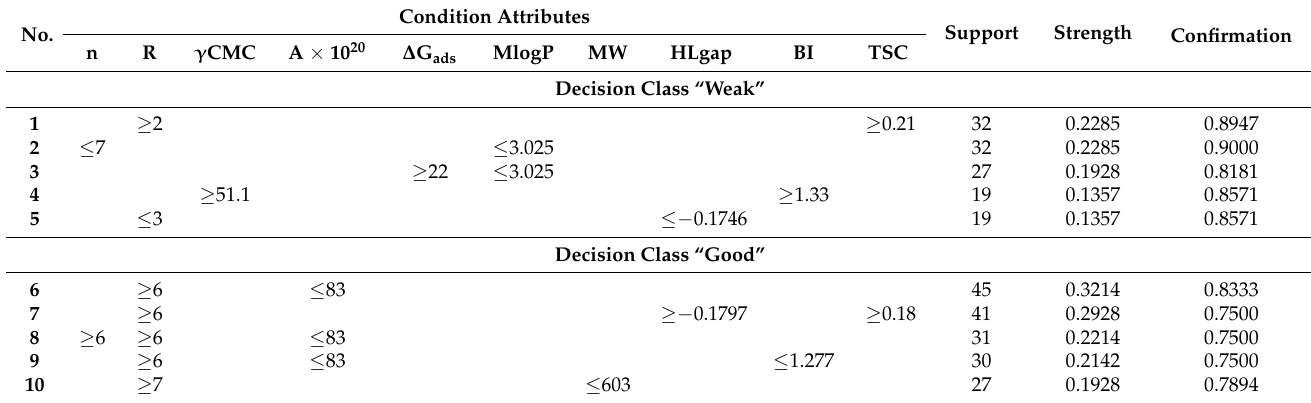
Table 2. Decision rules for